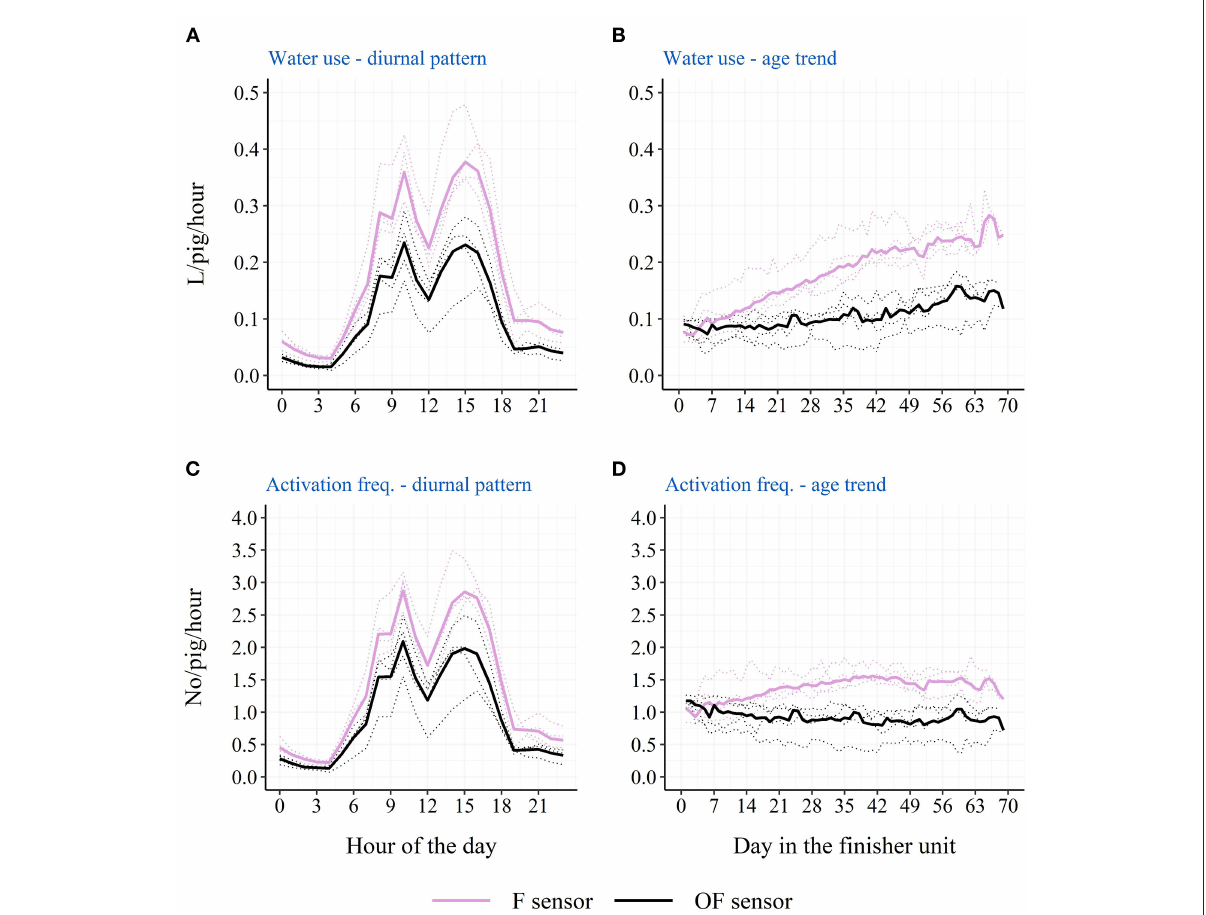
FIGURE6 Descriptive diurnal pattern (A) and age trend (B) in the water use in finisher pigs as well as the diurnal pattern (C) and age trend (D) in the activation frequency in finisher pigs for the two drinking cup sensor locations: F sensor (on the same side of the pen as the feeder) and OF sensor (on the opposite side of the pen as the feeder). Dotted lines represent each single batch, while solid lines represent the average across the four